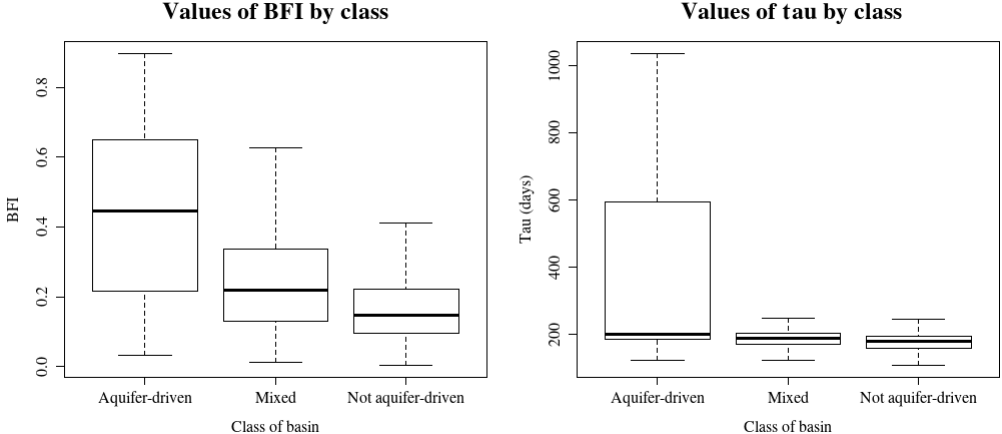
Figure 8. Boxplots of BFI values and τ according to the hydrogeological class of basins, i.e. whether they are likely to be under the influence of a significant aquifer. Central box accounts for the interval between first and third quartile; the segment in the middle is the median; whiskers represent the 95% confidence